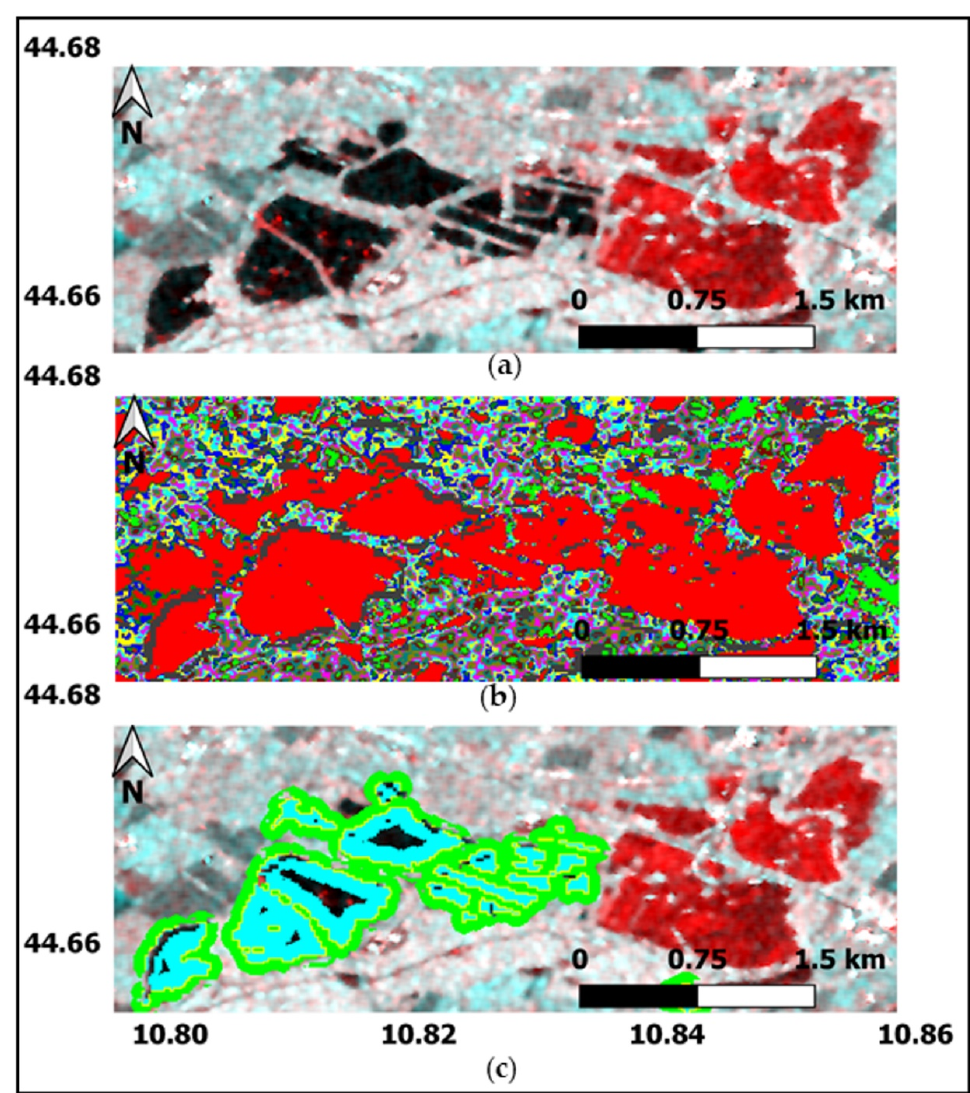
Figure 8. Panel ( a ): RGB false color images created using the S1 data gathered to produce the floodwater/permanent water map for the EMSR359 case study and zooming on the area affected by the flood; red: pre-flood image (at t 1 ), green/blue: flood image (at t 2 ). Panel ( b ): output of the ISODATA applied to the flood image (CDWA in red). Panel ( c ): same as panel ( a ), but with superimposed the land-permanent water edge (yellow), the buffer zone included in the MCDWA (cyan) and the buffer zone included neither in the MCDWA, nor in the CDWA